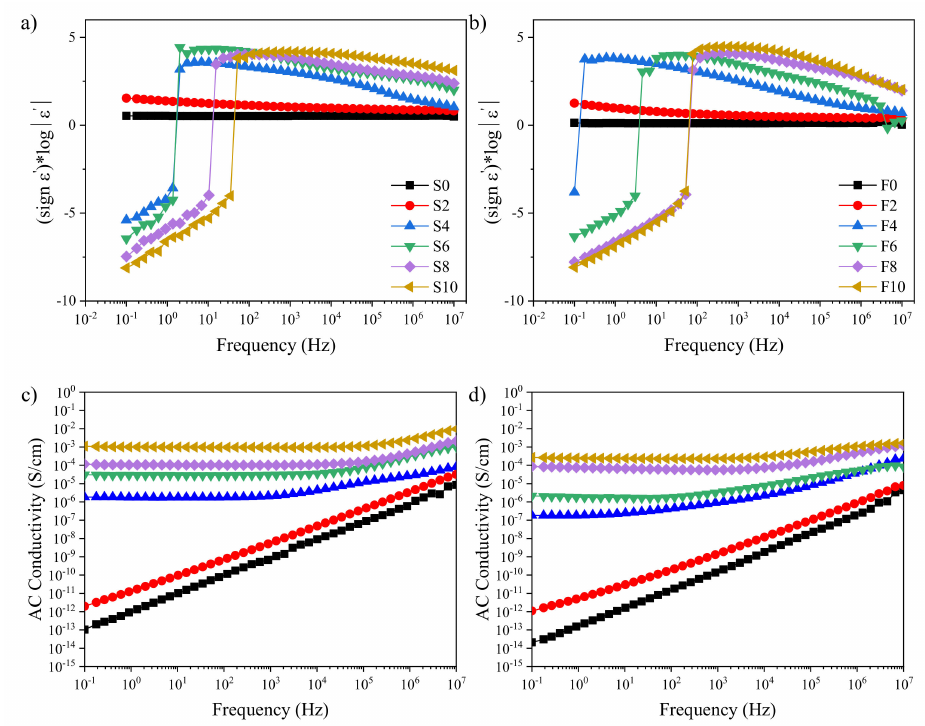
Figure 3. Logarithmic plots of ε ’ ( a , b ) and AC conductivity ( c , d ) as a function of frequency for solid (left) and foam (right)